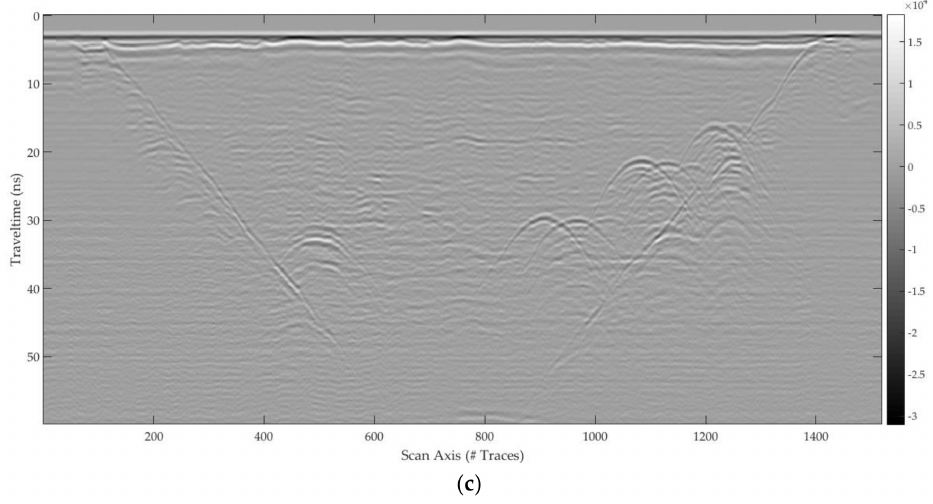
Figure 31. Profiles recorded in the Gneiss 14/20 gravel region by using GPR 1, on acquisition line 2,